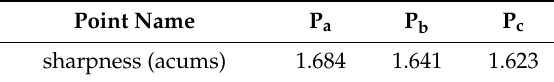
Table 3. Sharpness of three sound field points.